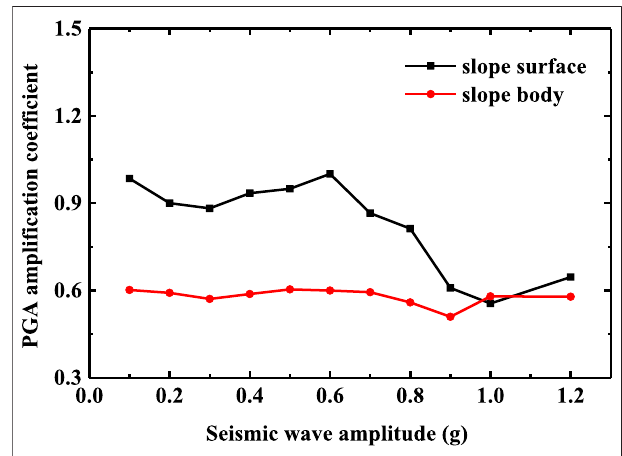
FIGURE 10 | Difference of PGA ampli fi cation coef fi cient between slope surface and slope body (the slope waist).